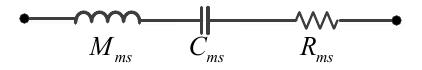
Figure 3. Equivalent circuit of mechanical domain.